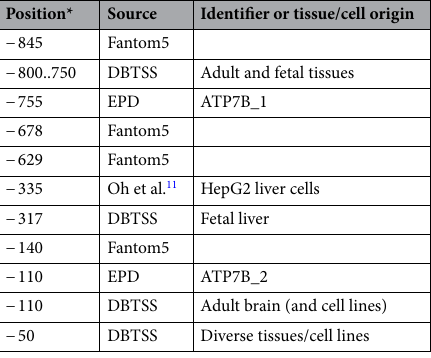
Table 1. Transcriptional start sites reported in the ATP7B promoter. *Positions are given relative to the translational start codon of ATP7B (NM_000053.4). EPD, Eukaryotic promoter database 23,24 . DBTSS, Database of transcriptional start sites 25 . Fantom5, database of the FANTOM consortium 26 ; Oh et al. 11